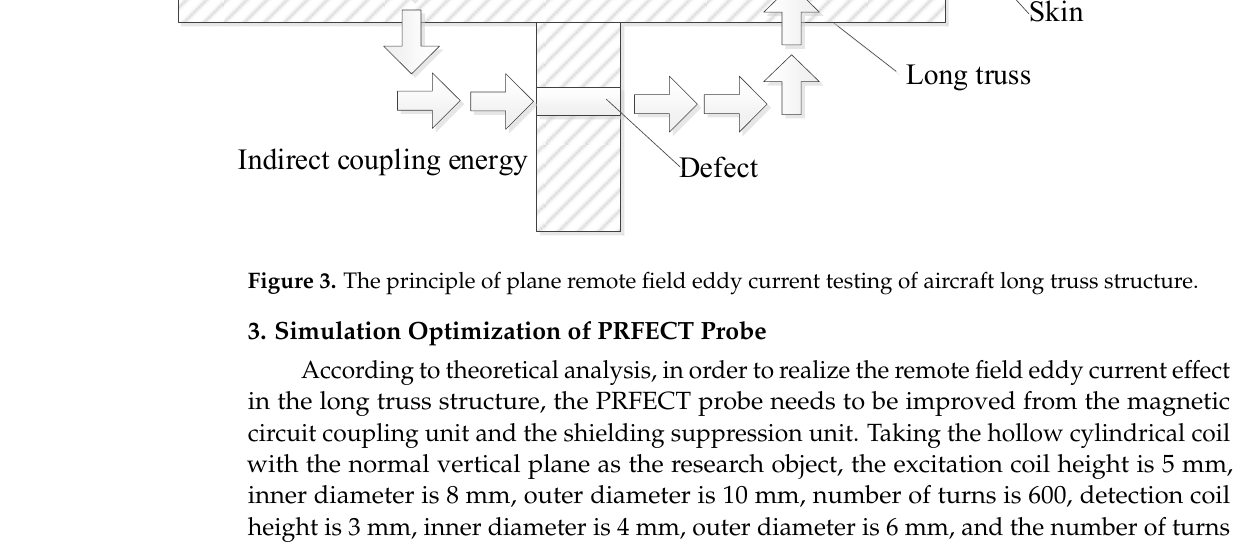
Figure 3. The principle of plane remote field eddy current testing of aircraft long truss structure.